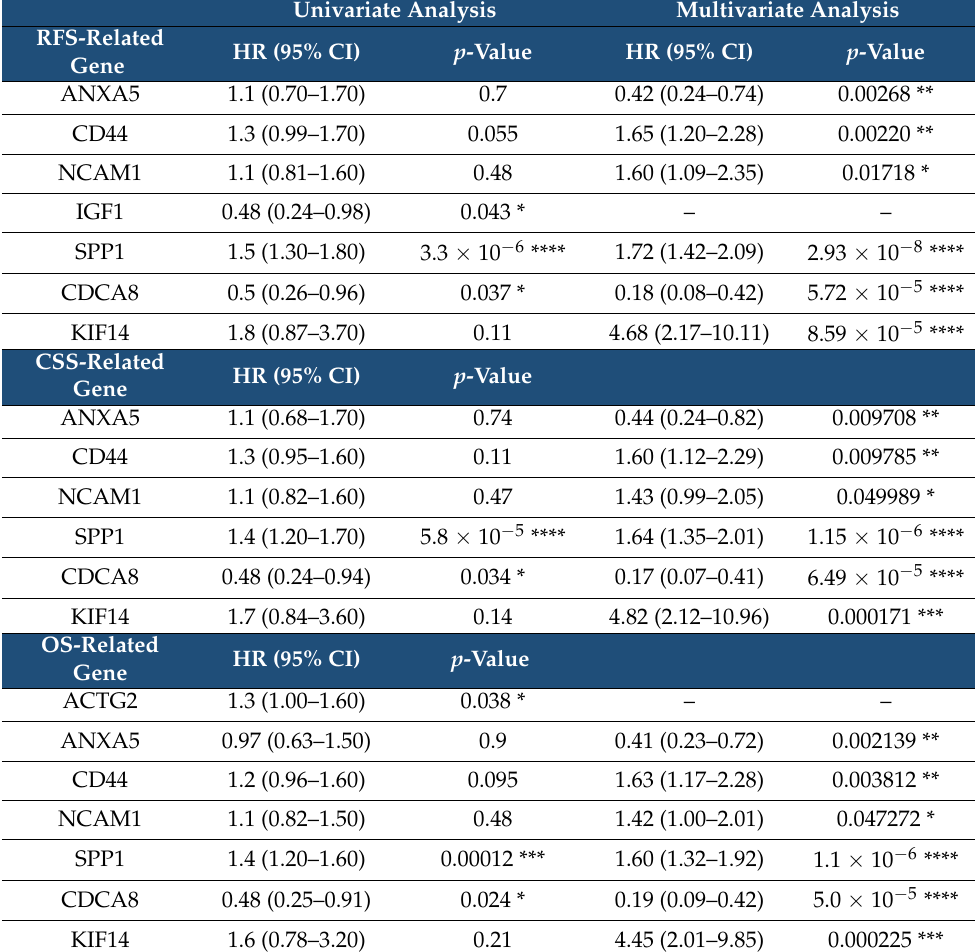
Table 6. Univariate Cox regression analysis of the survival-associated hub genes in MIBC patients receiving neoadjuvant cisplatin-based chemotherapy (HR: hazard ratio, CI: confidence interval, * p -value < 0.05, ** p -value < 0.01, *** p -value < 0.001, **** p -value <